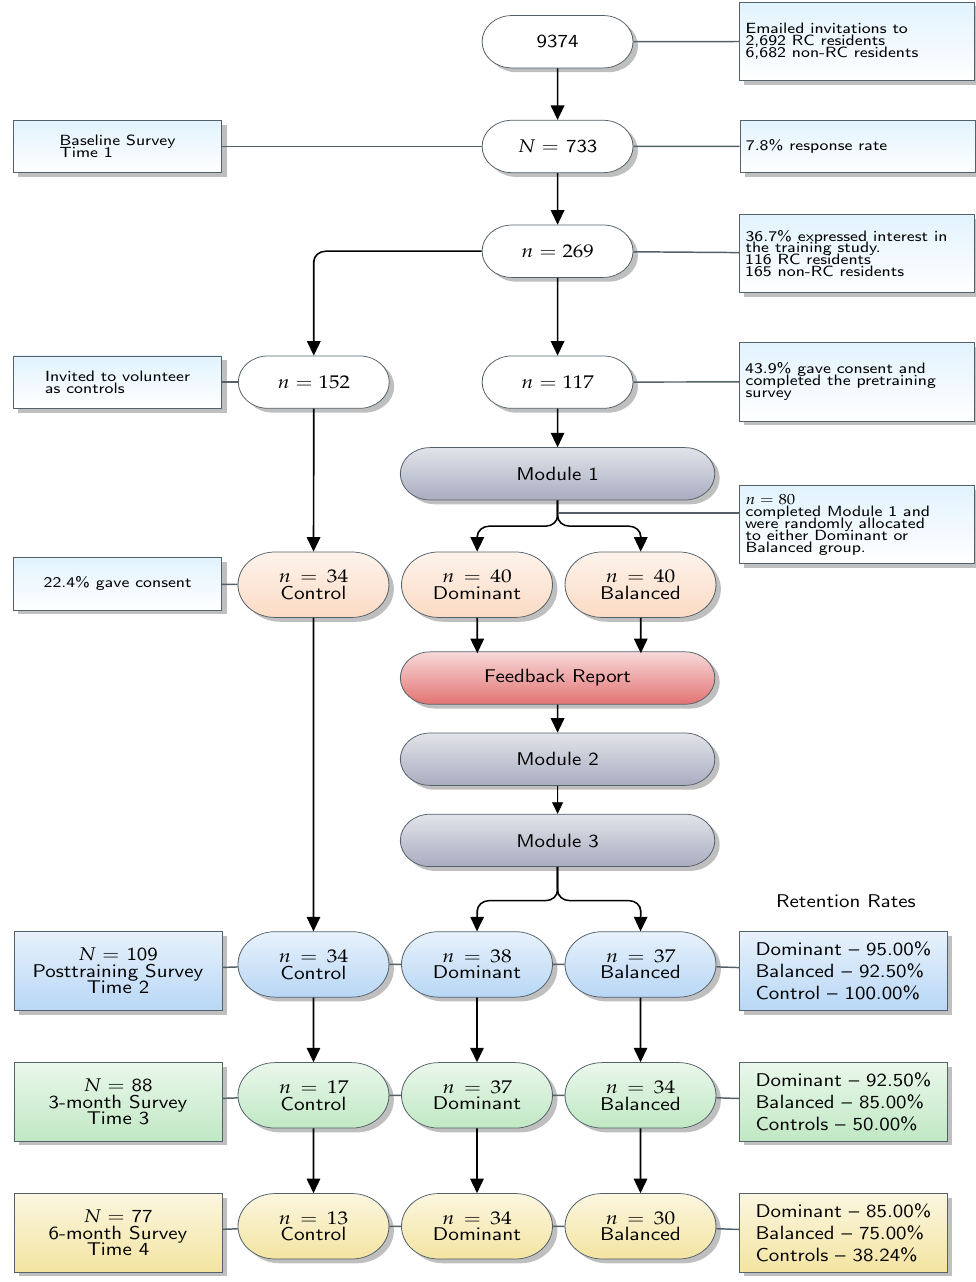
Figure 1. Study flowchart of the recruitment, training and follow-up process. RC = Retirement